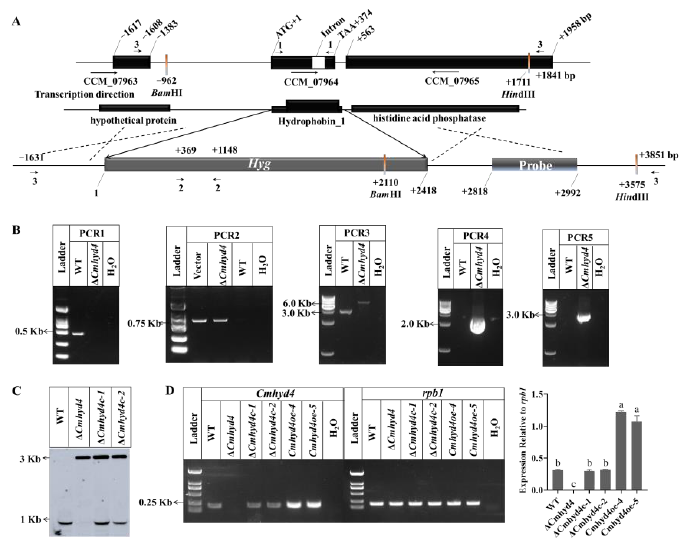
Figure 1. Generation and identification of the Cmhyd4 mutants. ( A ) Scheme for the ∆ Cmhyd4 strain obtained via homologous recombination; Cmhyd4 was replaced by the hygromycin resistance gene. ( B ) Confirmation of Cmhyd4 deletion by PCR. The primers 1, 2, and 3 were used to perform PCR1, PCR2, and PCR3, respectively; PCR4 and PCR5 were performed with the primers 3F/2R and 2F/3R, respectively. ( C ) Southern blot assay with double-digest sites BamH I and Hind III validating the Cmhyd4 gene deletion and complementation strains. Lane 1: WT; lane 2: ∆ Cmhyd4